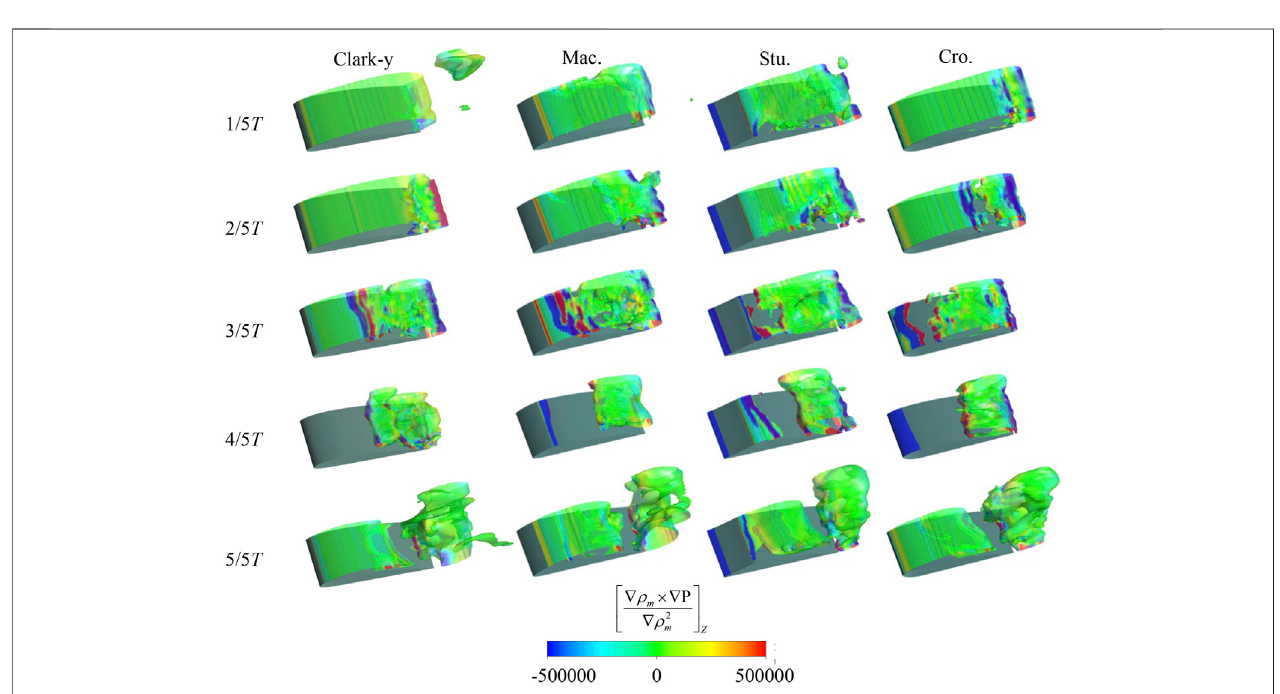
FIGURE 13 | Comparison of the Z-direction vortex baroclinic term evolution of the four hydrofoils in a typical cycle.